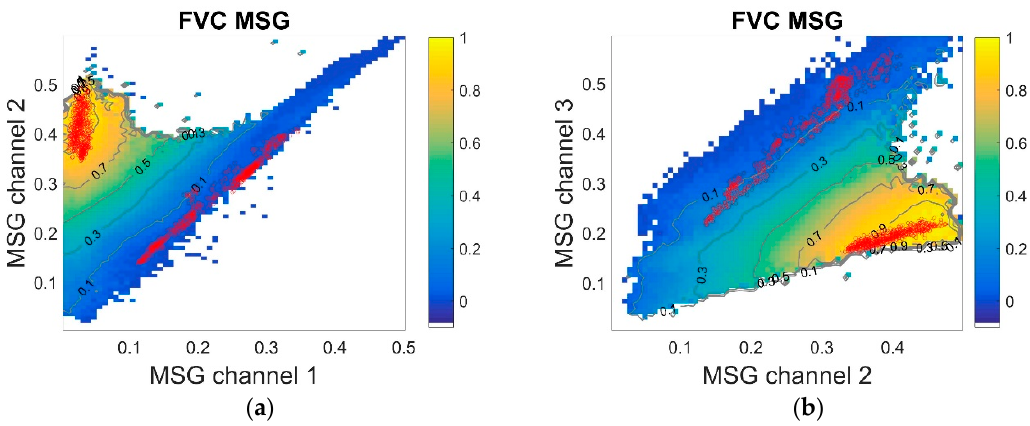
Figure 5. Projection of the SEVIRI/FVC product corresponding to the 15th of June 2015 onto the k 0 feature space of ( a ) channels 1 and 2; ( b ) channels 2 and 3. Red circles correspond to soil and vegetation pure pixels for the Southern Africa (SAfr) region.